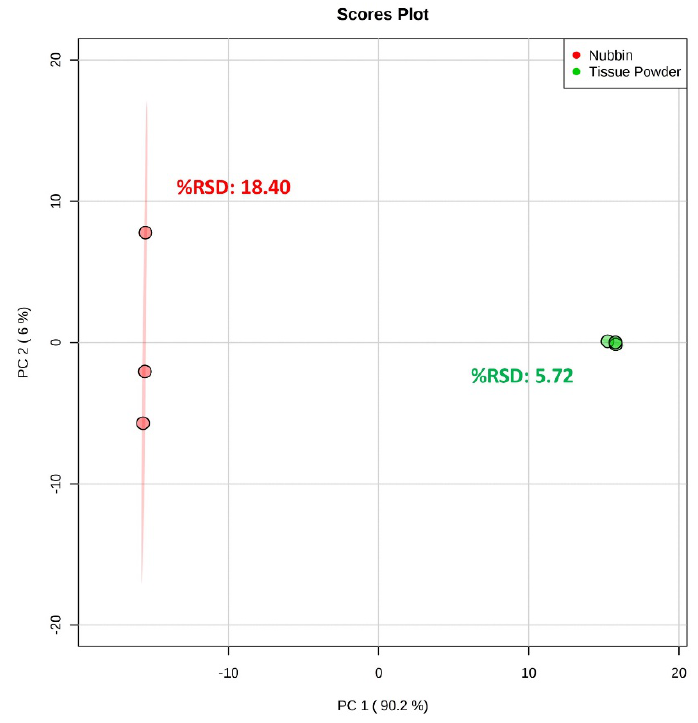
Figure 4. PCA score plot and spectral %RSD values comparing nubbin ( n = 3) and tissue powder ( n = 3) subsampling methods for unaffected Porites compressa . Samples were lyophilized and metabolites were extracted using the Bligh and Dyer extraction method. Ellipses indicate the 95% confidence region for each subsampling method.